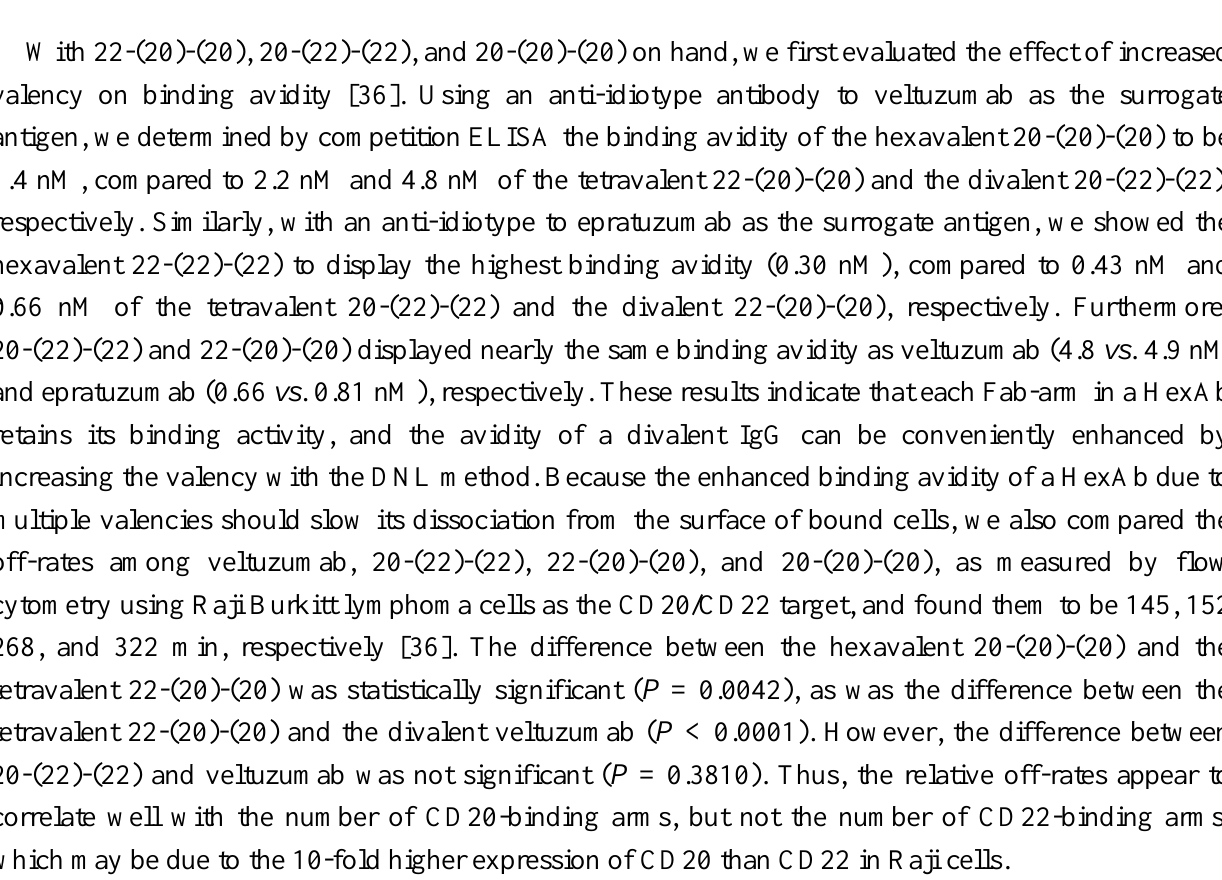
Table 2. Codes, modules, and targets of selected C